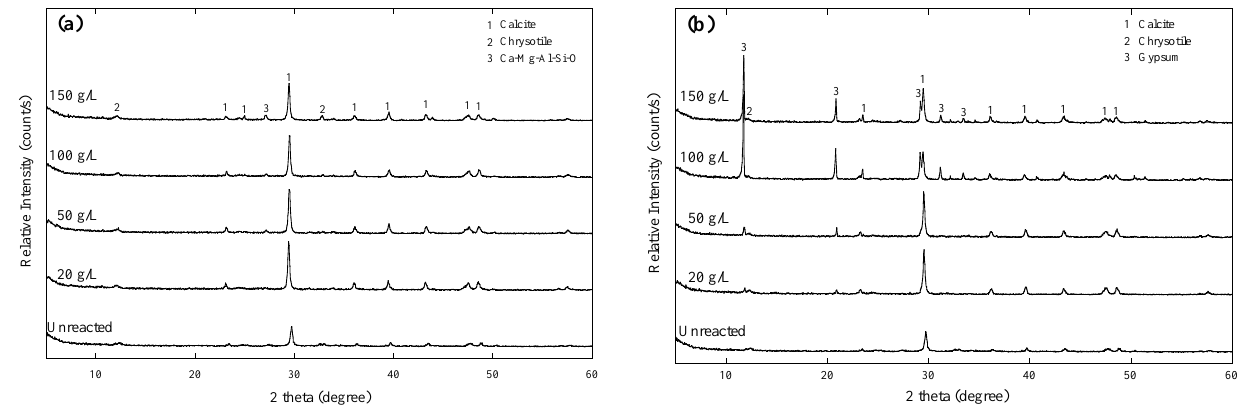
Figure 8. X-ray diffraction (XRD) patterns of unreacted waste slate (Unreacted) and reacted waste slate samples obtained from carbonation tests using ( a ) 1 M CH and ( b ) 1 M NH HSO solutions at various solid dosages (20, 50, 100, and 150 4 4